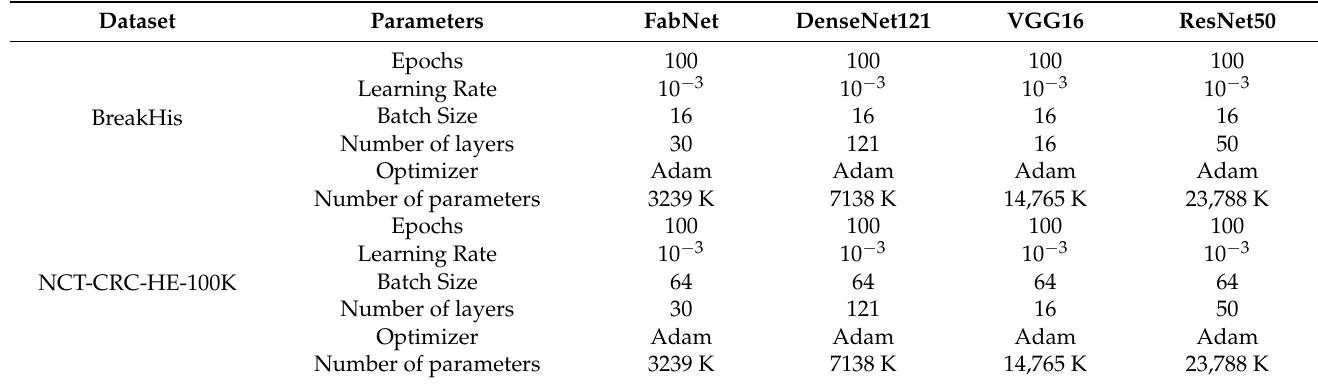
Table 3. Optimized hyper-parameters for FabNet, Densenet121, DNet, VGG16, and ResNet50.